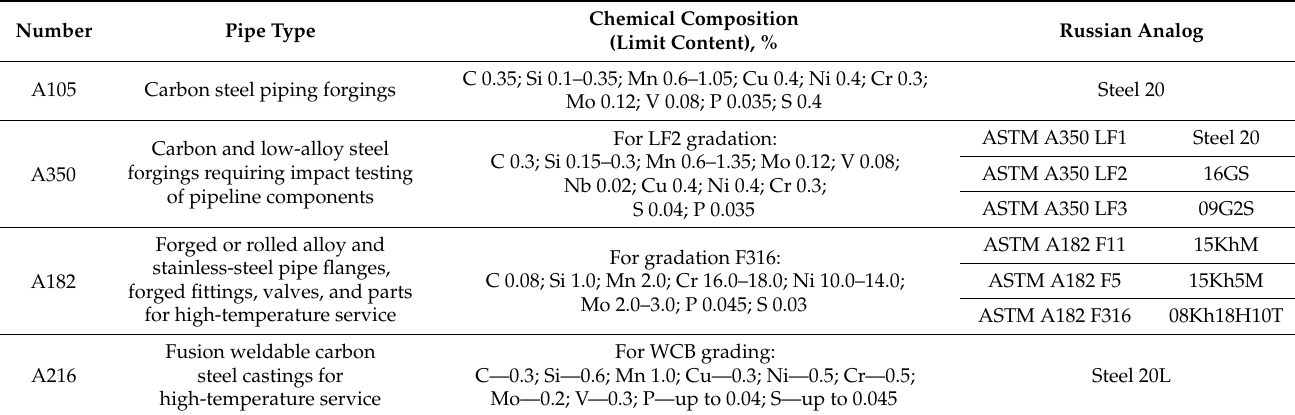
Table 12. Steel pipelines and component part IP [84].